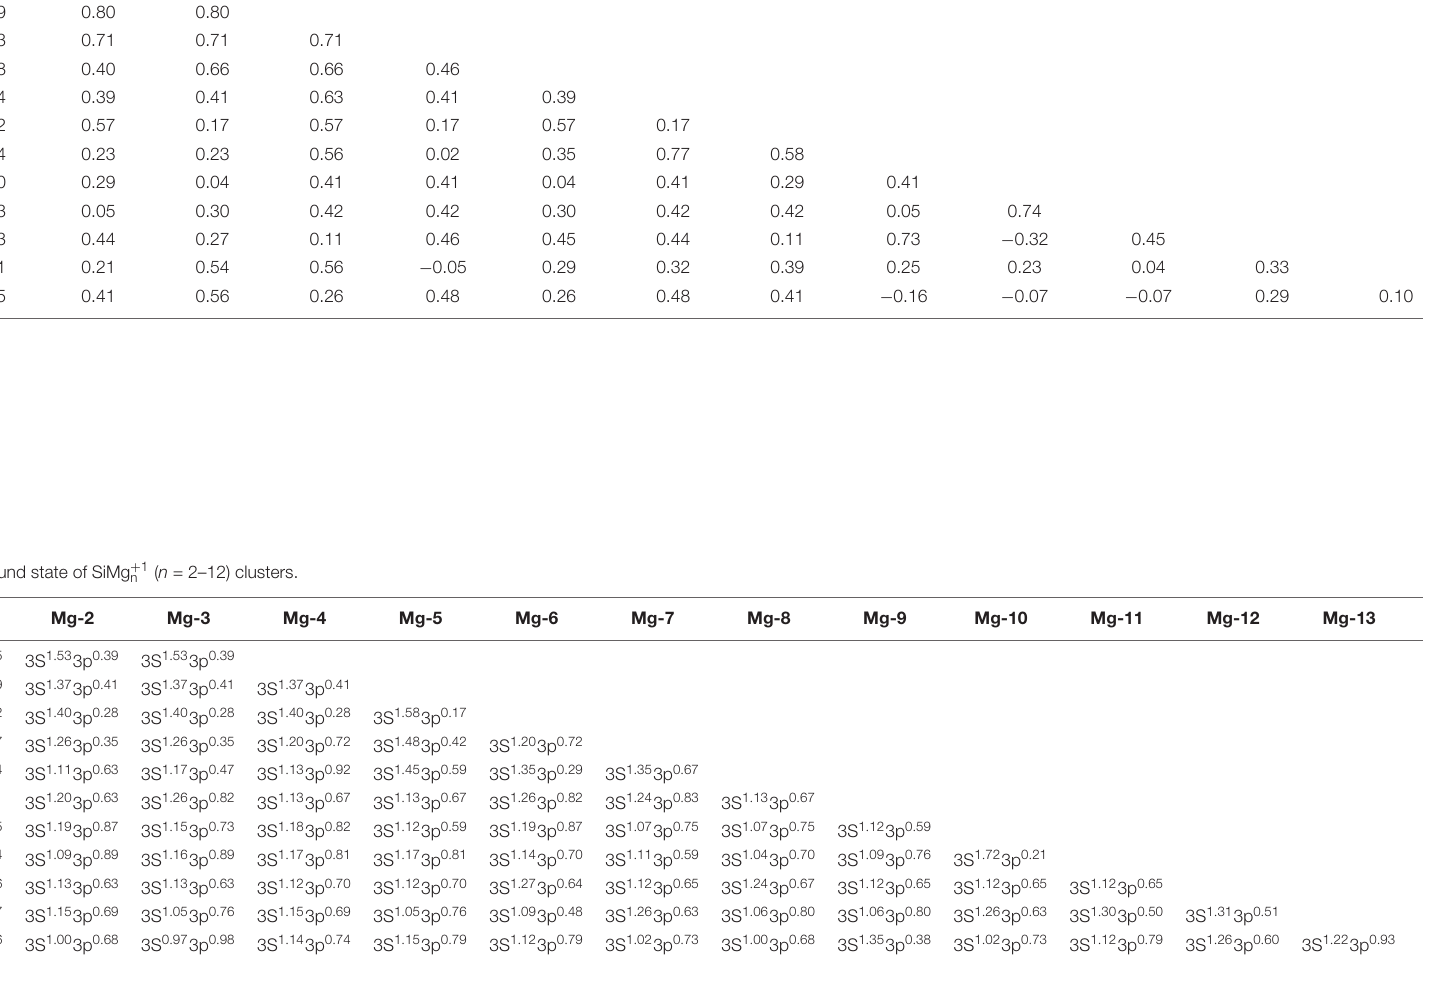
TABLE 4 | NEC of the ground state of SiMg − 1 n ( n = 2–12) clusters. Clusters Si-1 Mg-2 Mg-3 SiMg + 1 2